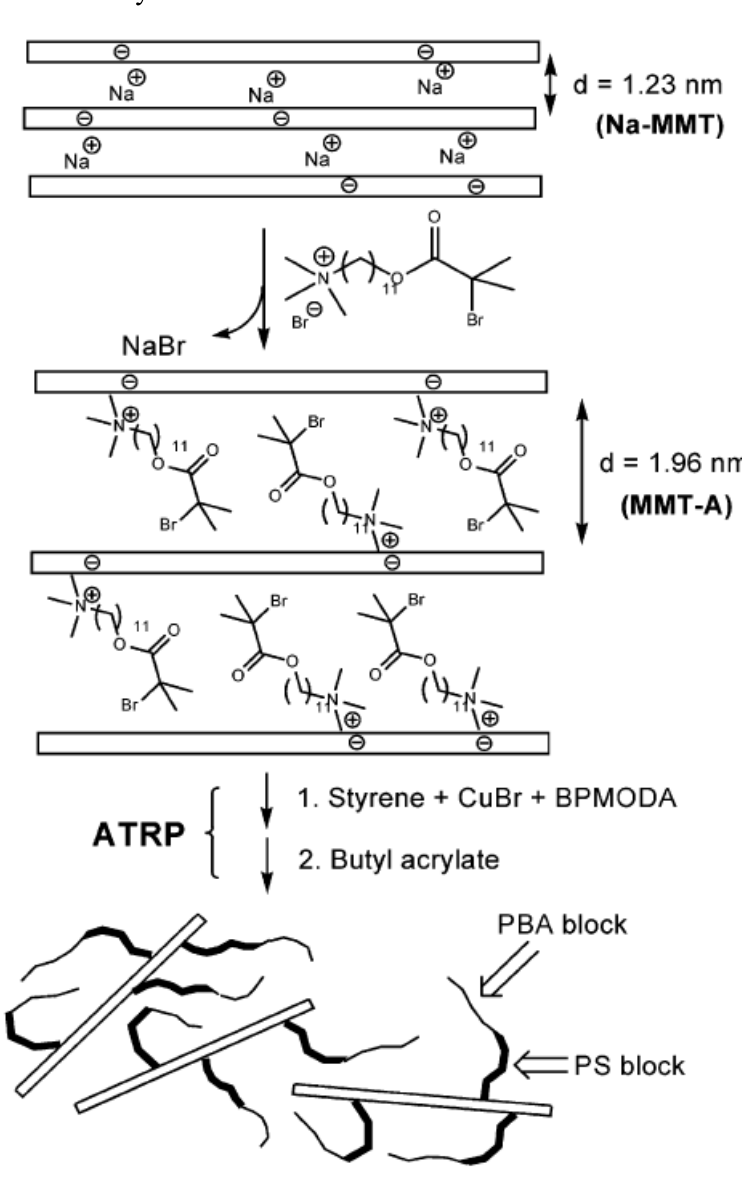
Figure 19. Synthesis of block copolymer layered silicate nanocomposites by using atom transfer radical polymerization. Reproduced from reference [84] by permission from The American Chemical